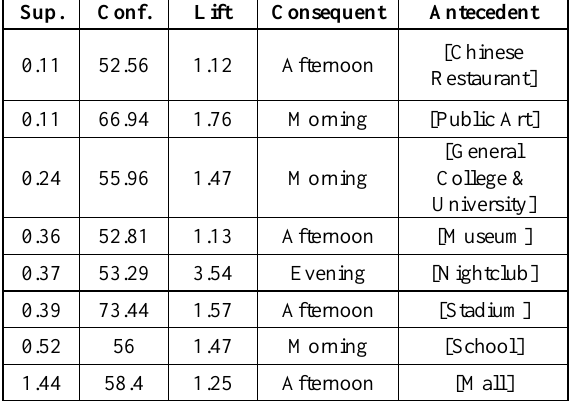
Table 3. A number of mined rules presenting the dependency of activity level in different place categories on the time context.